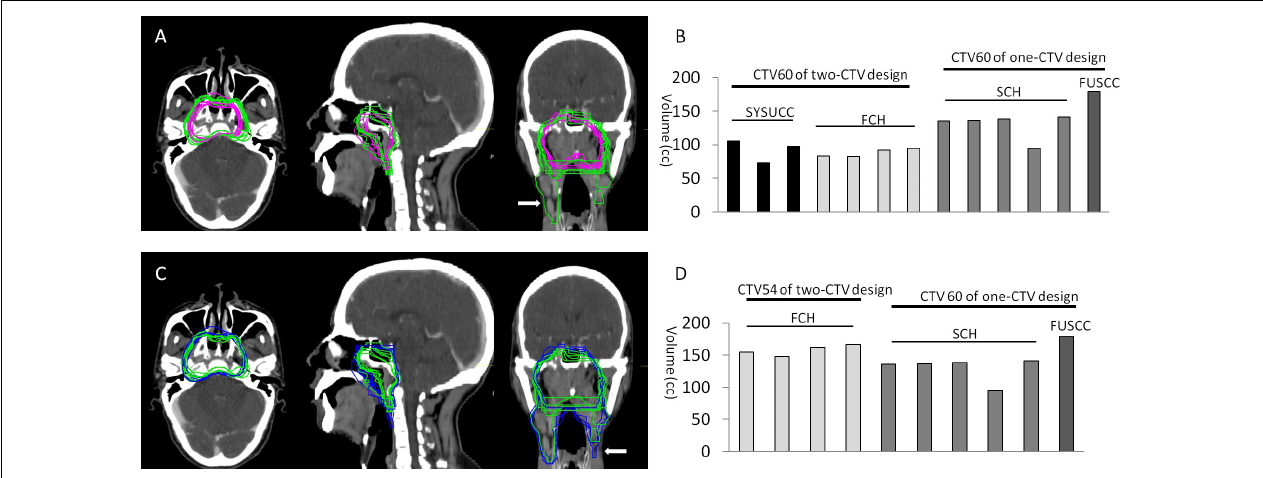
FIGURE 1 | Comparison of CTV volume. (A) Overview of CTV60s in transverse, sagittal, and coronary sections. Note that CTV60 of CHCAM also covers part of cervical lymph node area (white arrow in coronary figure). (B) Comparison of volume of CTV60. The volume of CTV60 from two-CTV design group (FCH AND SYSUCC) is significantly smaller than one-CTV design group (FUSCC and SCH, p ≤ 0.006, t test). (C) Overview of CTV60s from one-CTV design and CTV54 from CTV54 from two-CTV design. CTV54 from SYSUCC also covers cervical area (white arrow in coronary figure). (D) The volume of CTV54 from FCH (two-CTV design) is significantly bigger than CTV60 from SCH (one-CTV design, p = 0.027), but if FUSCC is put into the analysis, the difference is not statistically significant ( p = 0.131, t